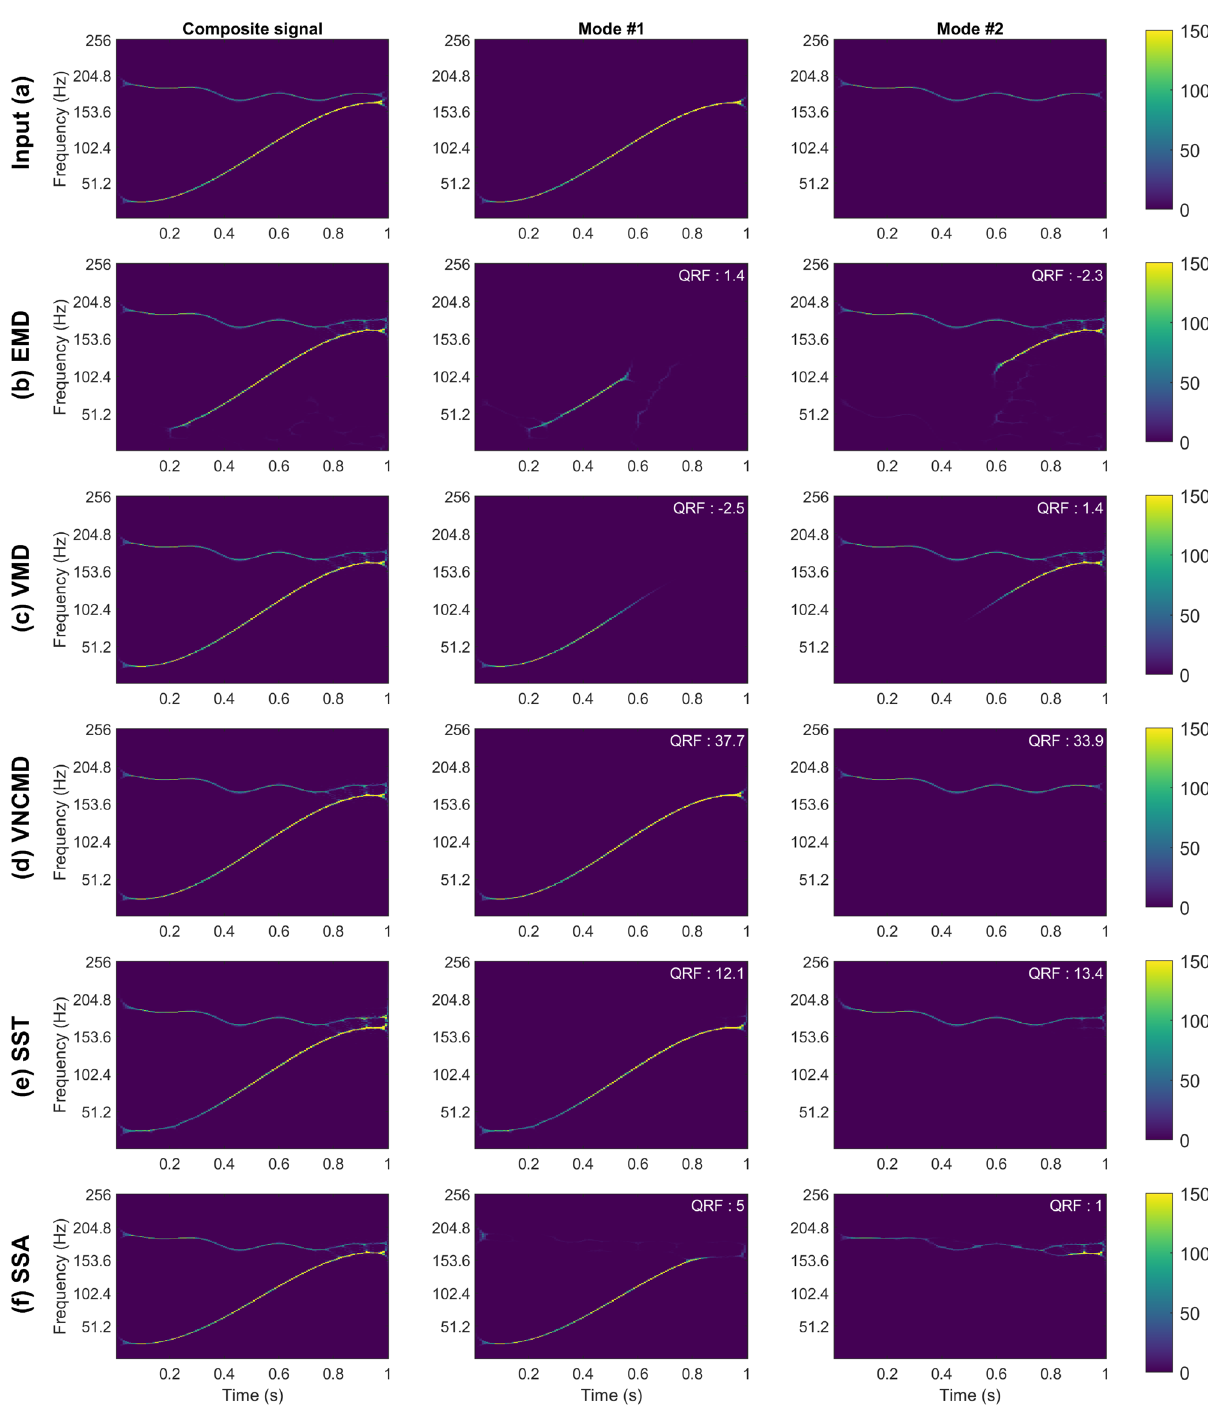
Figure 3. Performance evaluation of SD and T–F approaches on the wide-band synthetic signal. Plot ( a ) shows the original signal with each of its different modes separately. Similarly this is done for each method, EMD, VMD, VNCMD, SST and SSA in plots ( b – f ), where the reconstructed signal is shown together with the respective modes that are extracted. QRF is calculated with respect to the corresponding original signal component and shown in the upper right corner of each T-F